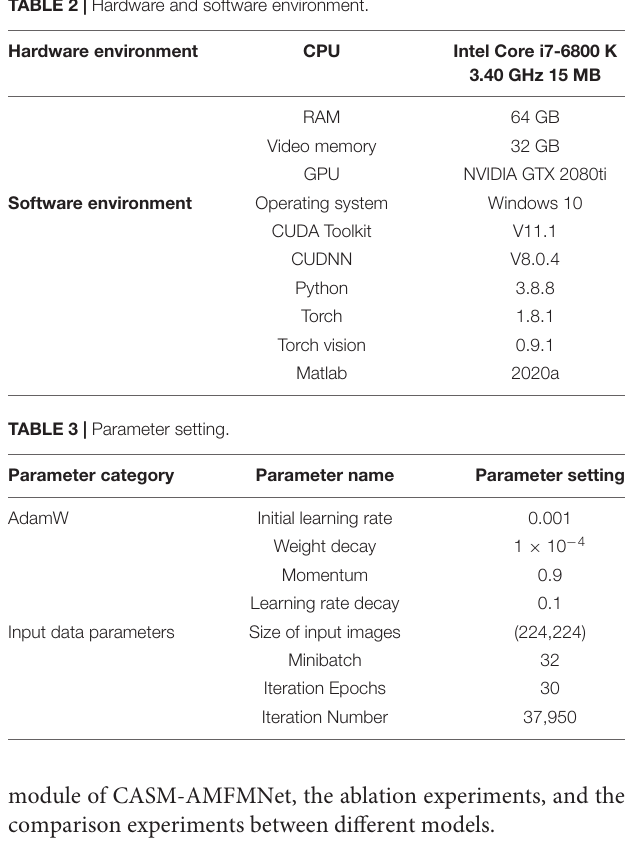
TABLE 2 | Hardware and software environment.